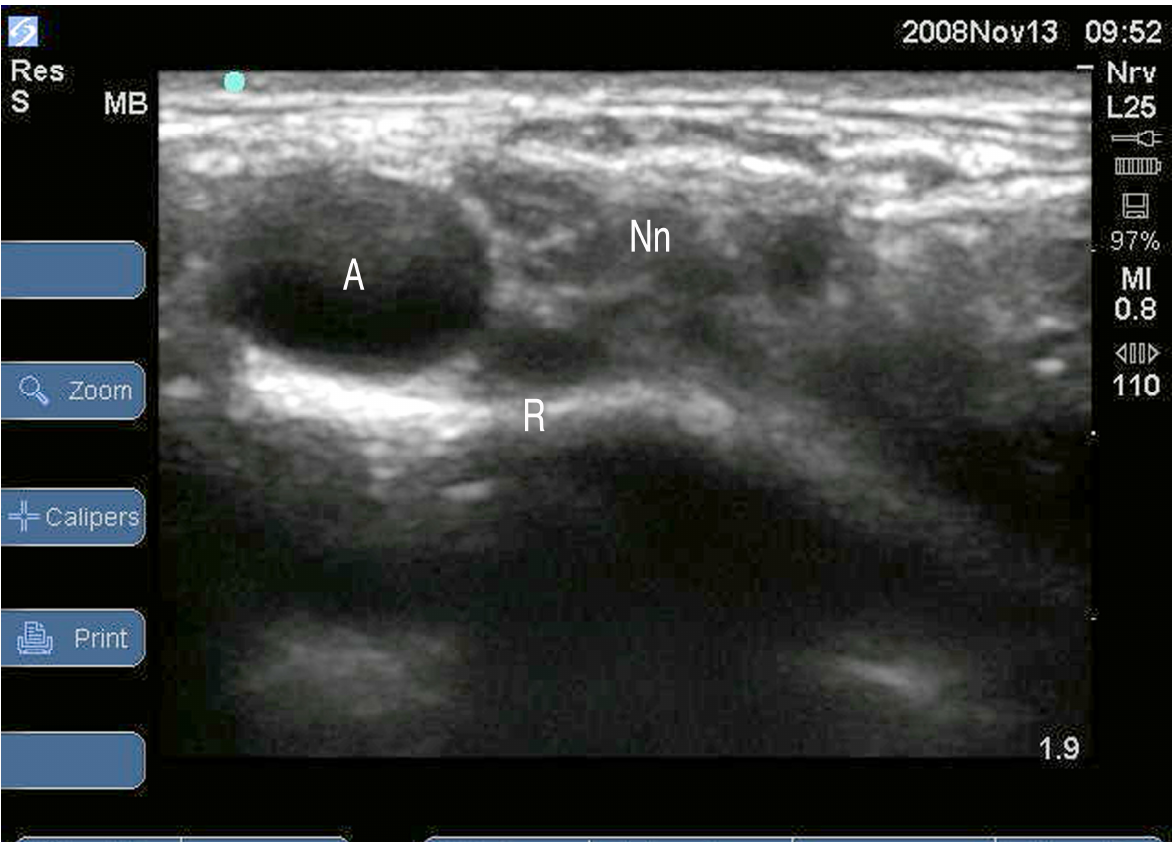
FIGURE 3. Ultrasound scan of supraclavicular region, revealing the nerve elements of the brachial plexus, clustered lateral to the artery. A, subclavian artery; R, first rib; Nn, nerves of brachial